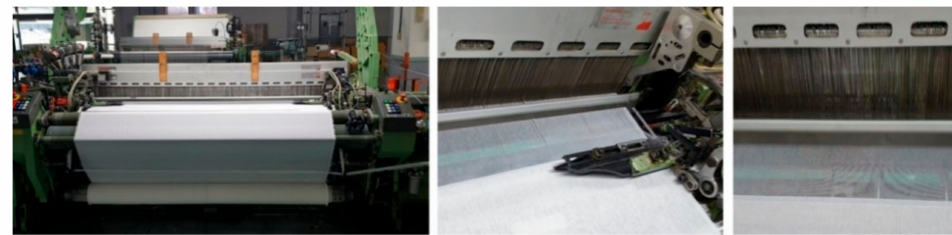
Figure 2. Tungsten yarn and fabric.